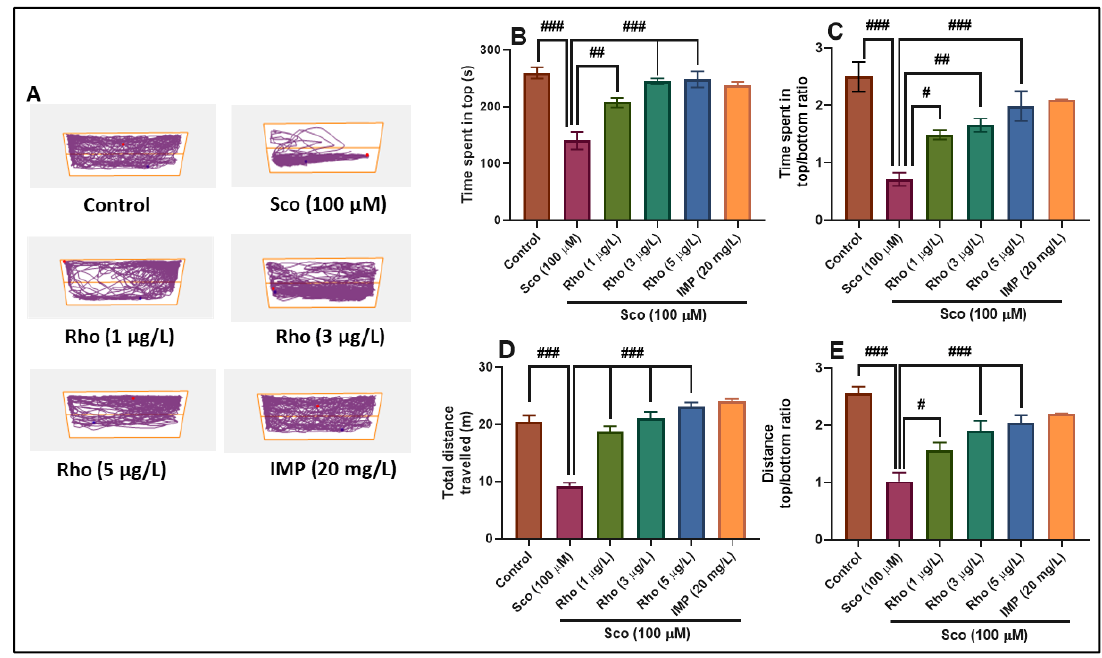
Figure 2. Rhoifolin (Rho: 1, 3, and 5 µ g / L) improved the locomotion pattern and reduced anxiety in the novel tank diving test (NTT). ( A ) Representative locomotion tracking pattern of the control, scopolamine (Sco: 100 µ M), rhoifolin (Rho: 1, 3, and 5 µ g / L), and imipramine (IMP: 20 mg / L) treated groups. ( B ) Representation of the time spent in the top zone by zebrafish in the tank in di ff erent groups. ( C ) Representation of the time spent in top / bottom ratio in di ff erent groups. ( D ) Representation of the total distance traveled by zebrafish in the tank in di ff erent groups. ( E ) Representation of the distance top / bottom ratio in di ff erent groups. The values are means ± S.E.M. (n = 10). For Tukey’s post hoc analyses: ( B ) Control vs. Sco (100 µ M): ### p < 0.0001, Sco (100 µ M) vs. Rho (1 µ g / L): ## p < 0.001, Sco (100 µ M) vs. Rho (3 µ g / L): ### p < 0.0001 and Sco (100 µ M) vs. Rho (5 µ g / L): ### p < 0.0001; ( C ) Control vs. Sco (100 µ M): ### p < 0.0001, Sco (100 µ M) vs. Rho (1 µ g / L): # p < 0.01, Sco (100 µ M) vs. Rho (3 µ g / L): ## p < 0.001, and Sco (100 µ M) vs. Rho (5 µ g / L): ### p < 0.0001; ( D ) Control vs.